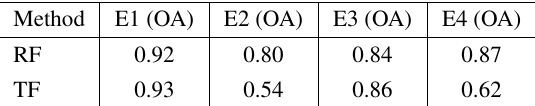
Table 2. Supervised benchmark with all bands and time steps: Overall accuracy (OA) with all data (E1); OA with 0% labels for